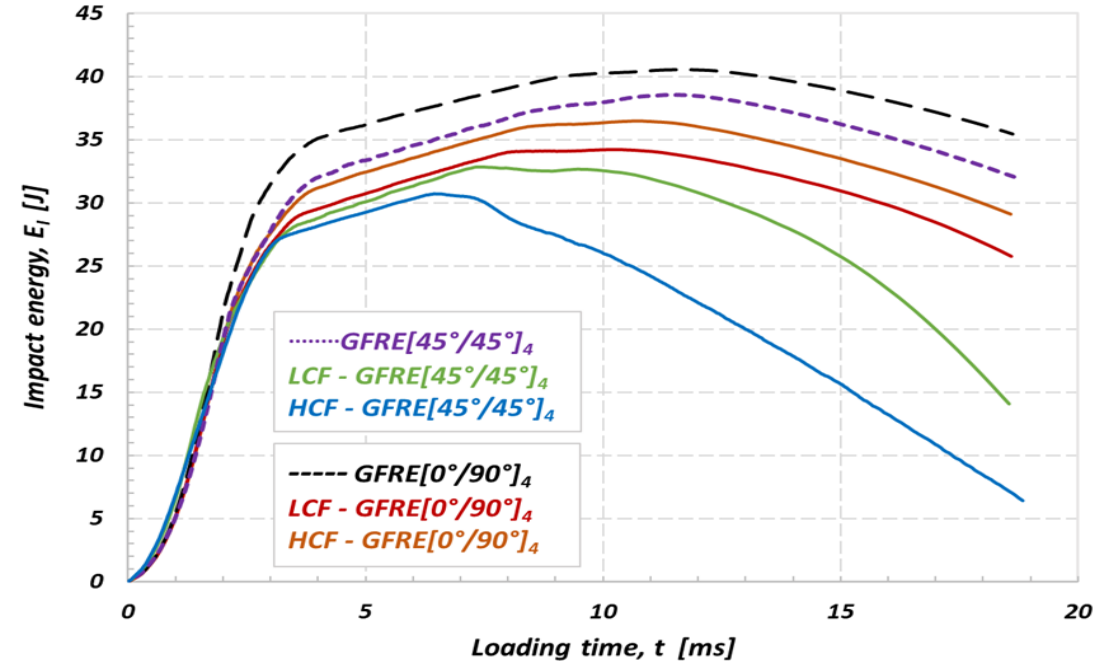
Figure 14. Effect of fatigue aging on the absorbed energy of the non-aged and aged GFRE for impact energy of 50 J at 20 °C.